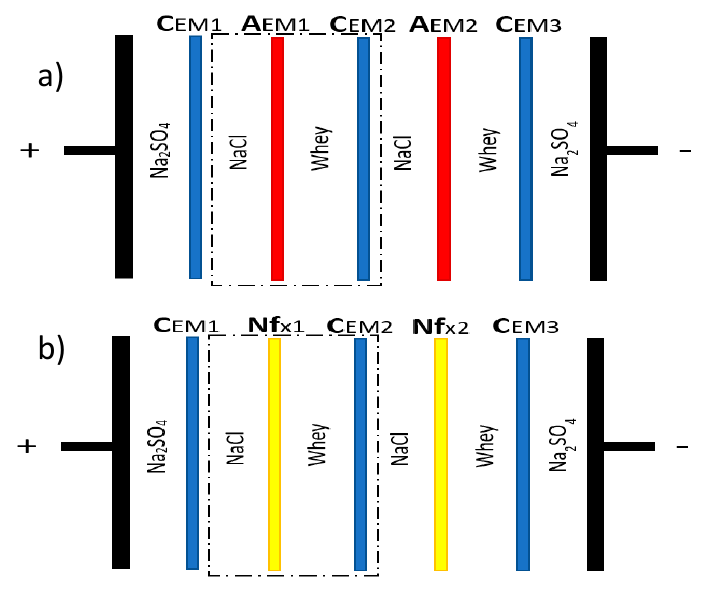
Figure 1. ED cell configuration ( a ) “CACAC” and ( b ) “CNfCNfC” used for acid whey deacidification and demineralization.